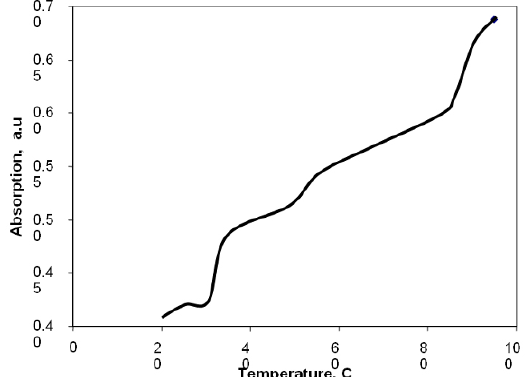
Figure 3. Temperature dependence of absorption at 440 nm for 0.2 g dL -1 ferrocenyl-disiloxane polyamide in